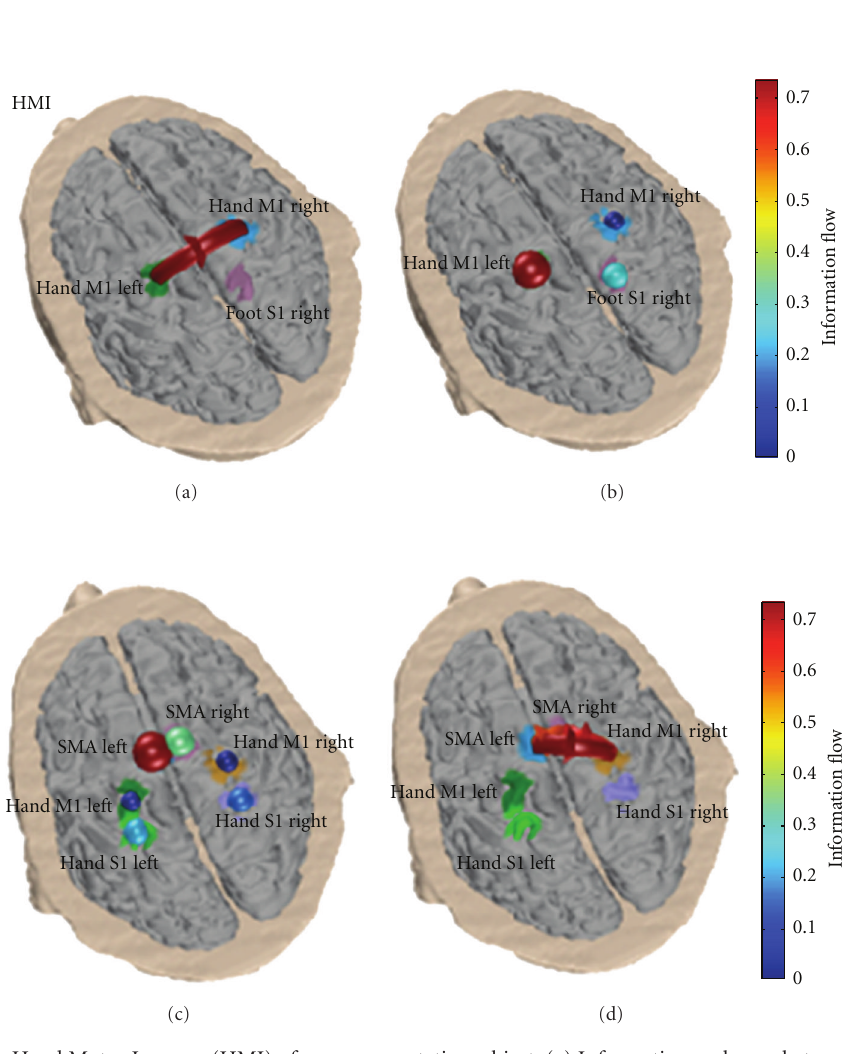
Figure 7: FCN during Hand Motor Imagery (HMI) of one representative subject. (a) Information exchange between primary hand motor areas, (b) information outflow from the same areas, (c) information outflow from SMAs, and (d) the highest information exchange was shown to occur between the two SMAs and the ipsilateral primary hand motor area. The size of the spheres is proportional to the outflow, which is also obvious from the chromatic